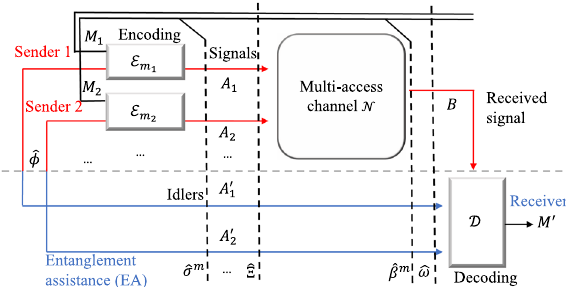
Fig. 2 Schematic of a general EA-MAC communication